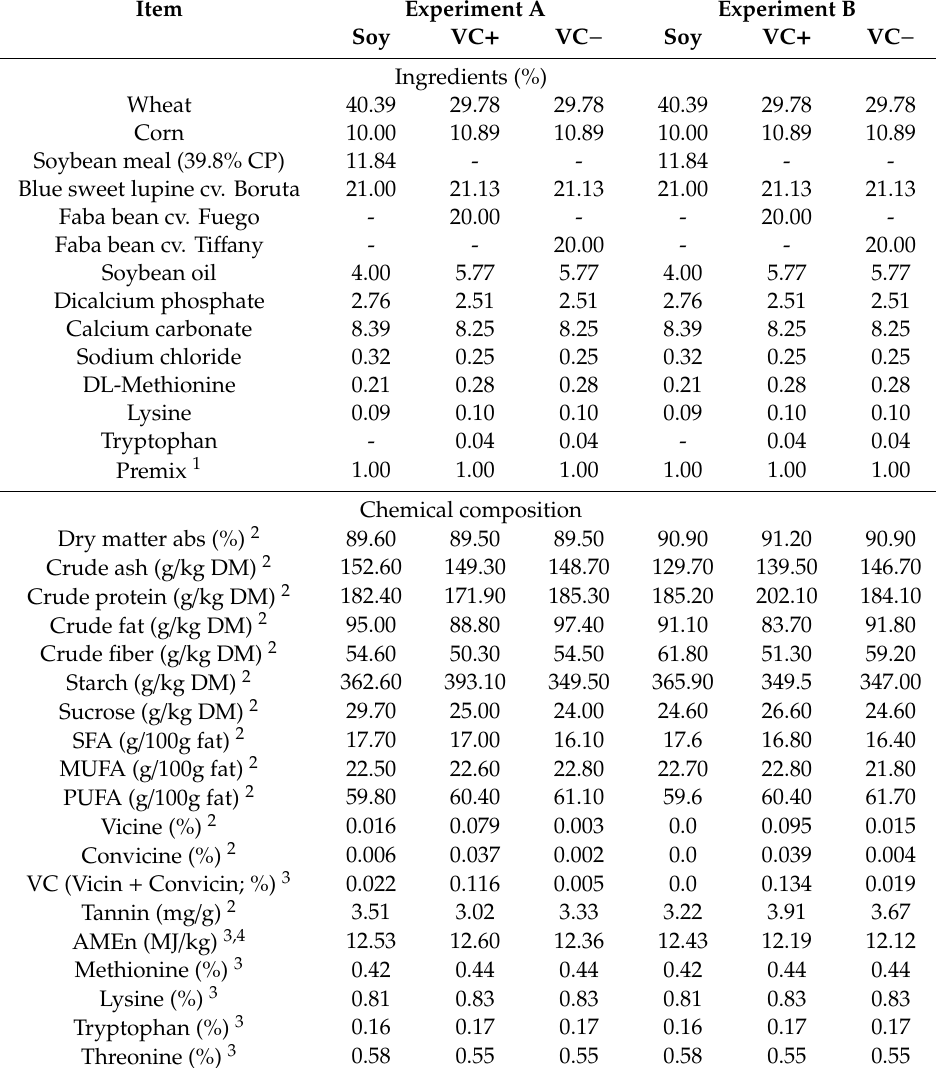
Table 1. Composition, analyzed and calculated nutrient composition of the experimental